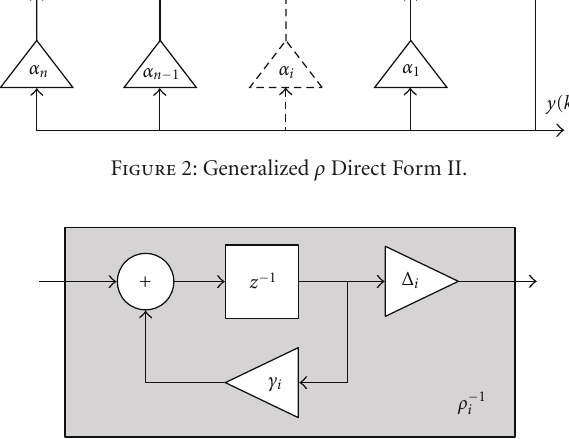
Figure 4: Fixed-point